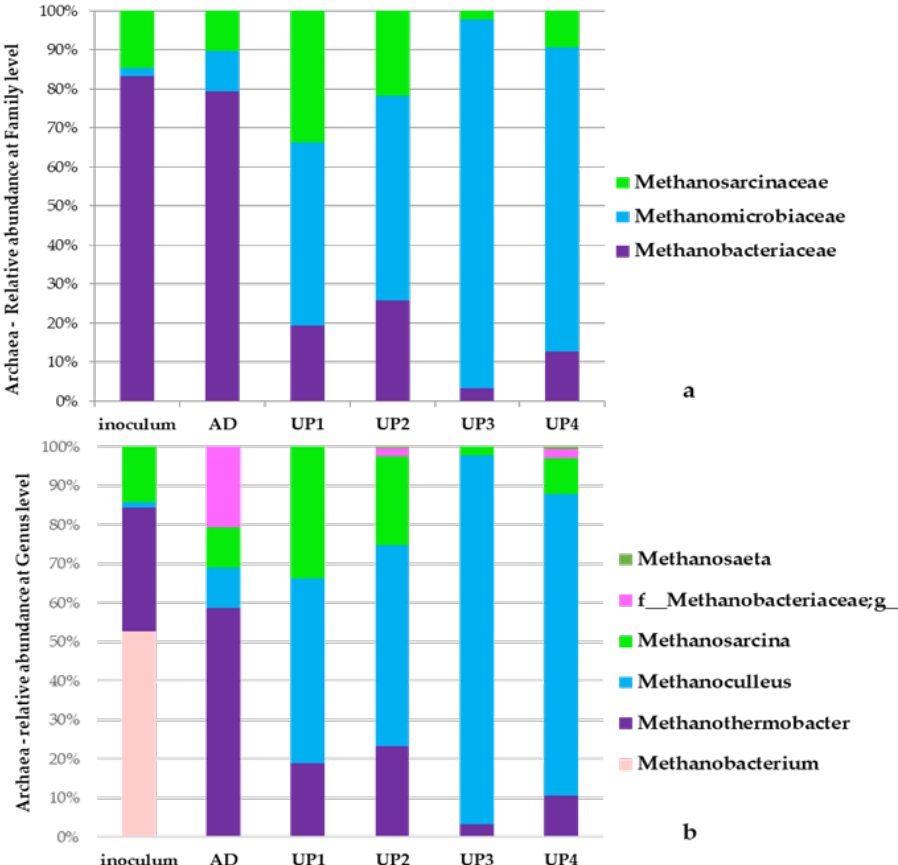
Figure 5. Relative abundance of the archaea community at the family ( a ) and genus ( b ) levels, both in the sludge used as inoculum and at the end of the AD and UP1, UP2, UP3, UP4 phases. Communities with a relative abundance >1% in at least one sample are reported.